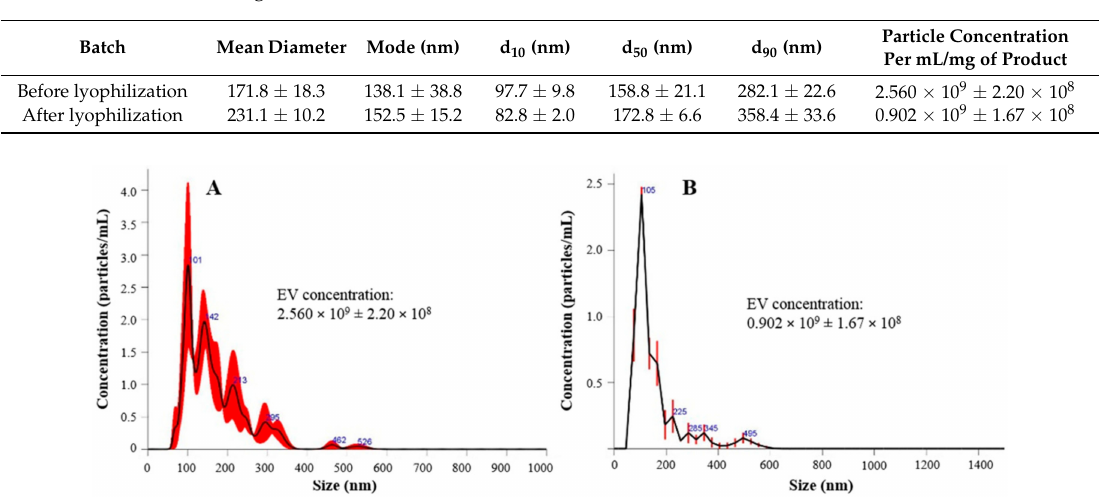
Table 3. EV particle size distribution and concentration before and after the lyophilization process (mean values ± standard deviation, n = 3). The EV particle concentration per mL corresponds to the EV particle concentration per mg, as for analysis freeze-dried samples were re-suspended to a final concentration of 1 mg/mL.